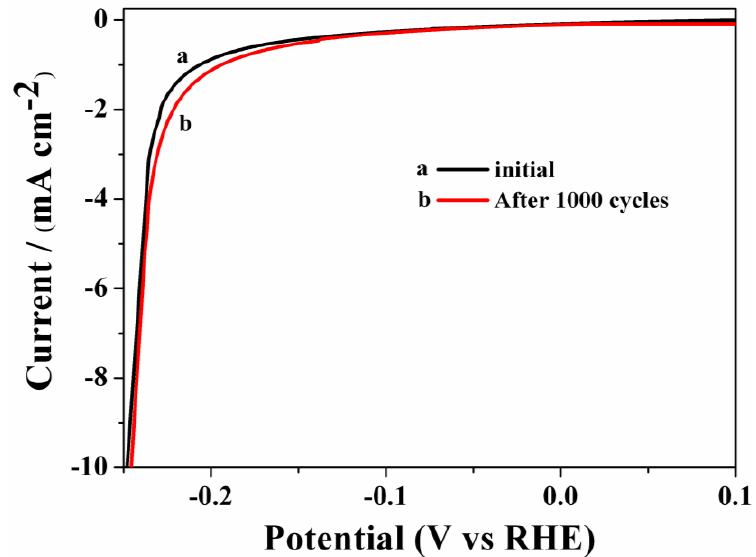
Figure 9. Stability test for the MoS 2 /PVA–0.04 composite. RHE = reversible hydrogen